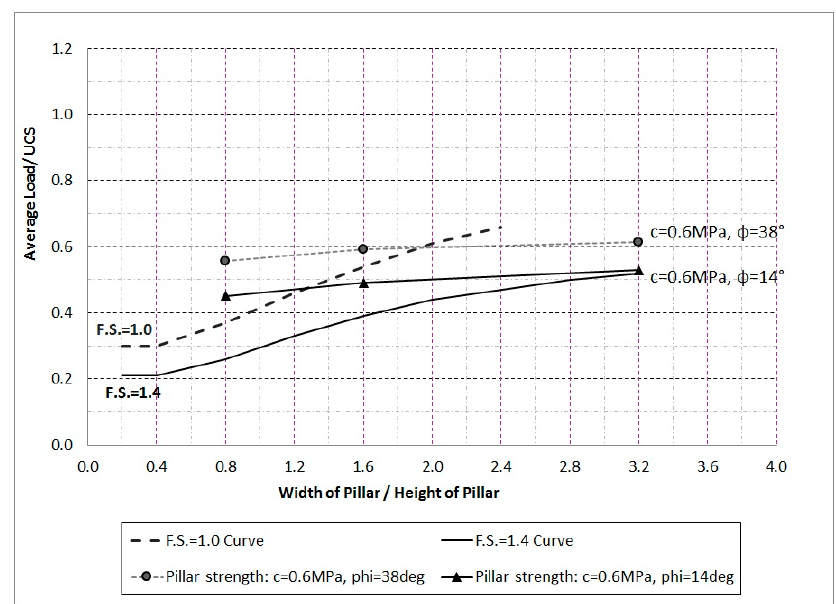
Figure 13. Effect of discontinuity friction angle on pillar strength.